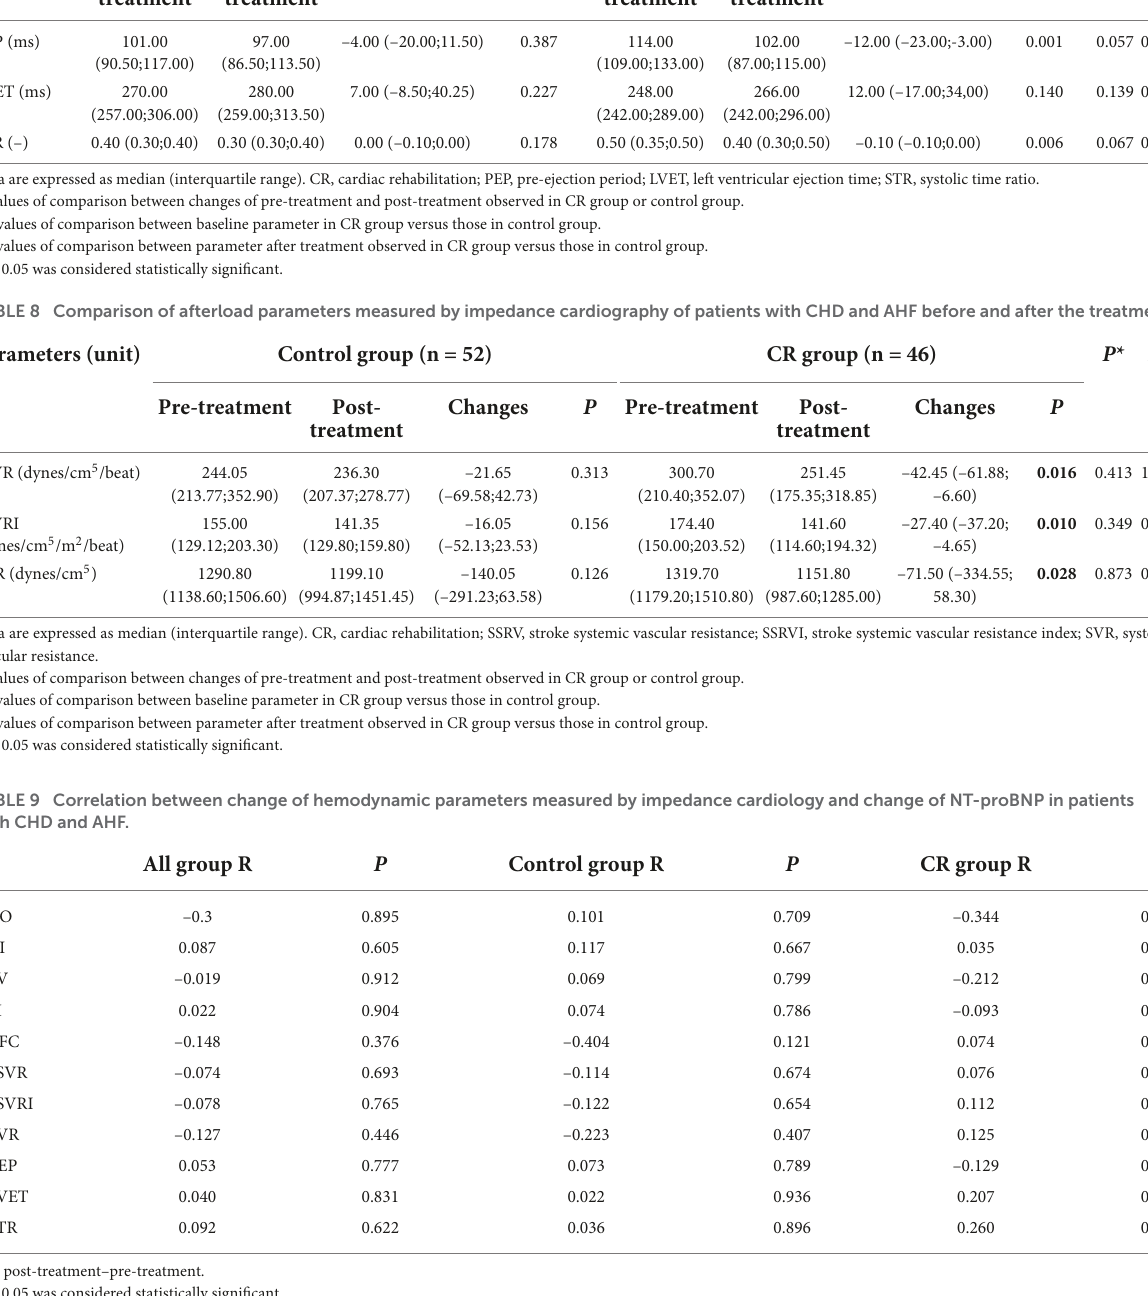
TABLE 7 Comparisons of cardiac function of contraction measured by impedance cardiography of patients with CHD and AHF before and after the treatment. Parameters Control group ( n = 52) (unit)